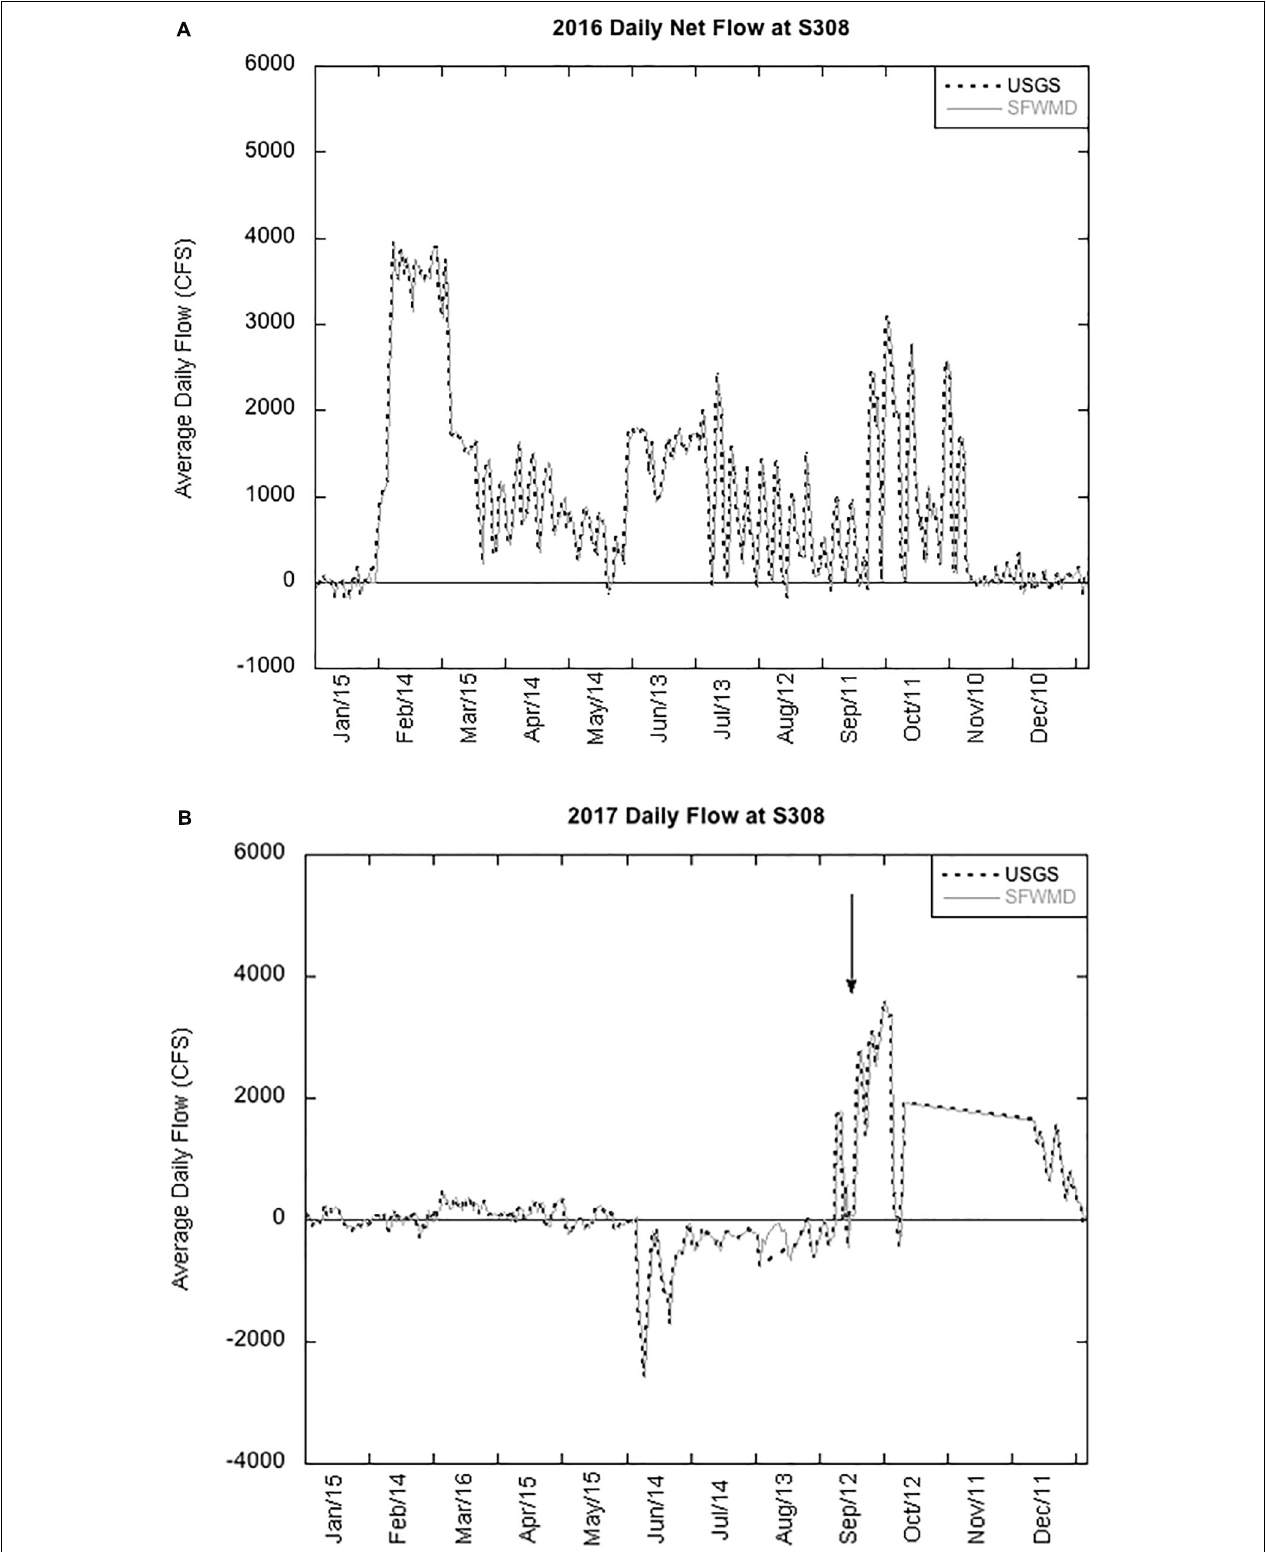
FIGURE 4 | Daily flow rates at the S308 lock between Lake Okeechobee and St. Lucie Estuary in 2016 (A) and 2017 (B) measured by U.S. Geological Survey (USGS) and South Florida Management District (SFWMD). The arrow points to increased flow during the Hurricane Irma disturbance.